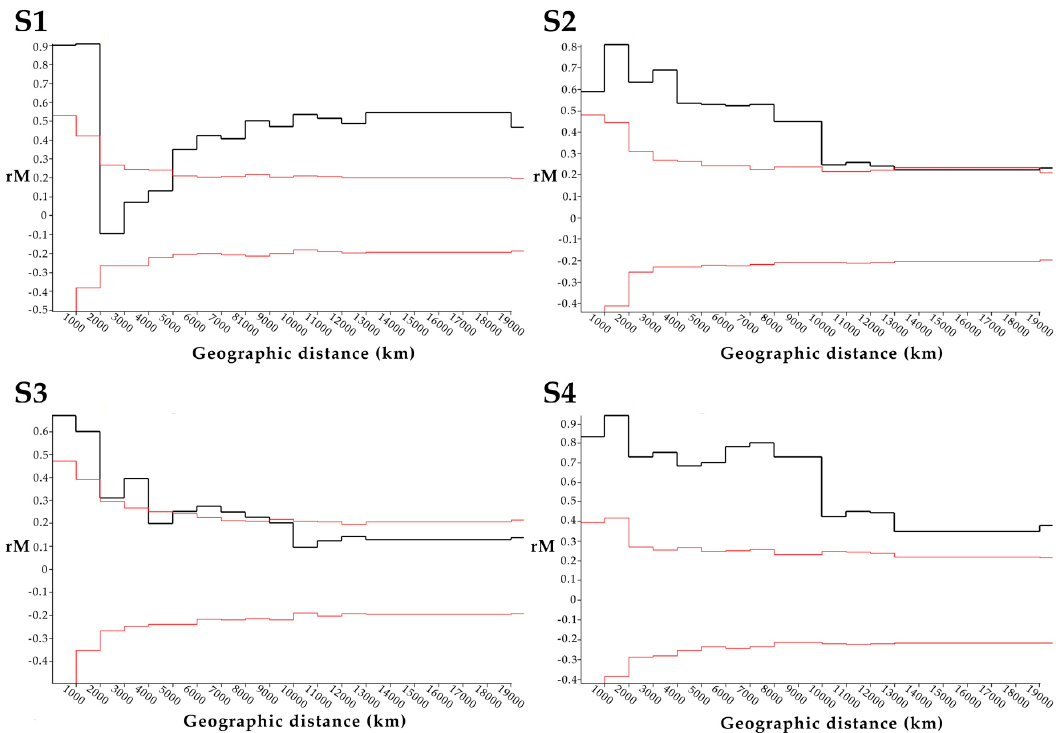
Figure 4. Mantel correlograms for segments S1-4 of 16 PRV isolates. The mantel correlograms show the relationship between geographic distance (km) and the correlation between pairwise genetic and geographic distances (Mantel’s r, or rM) across 20 distance intervals (1000 km). The black lines show Mantel’s r computed for each interval, while the red lines show the results of 10,000 random permutations (randomizing matrix associations). For each interval, Mantel’s r values (black lines) outside of the limits of the results of 10,000 random permutations (red lines) are considered significant (alpha = 0.5).